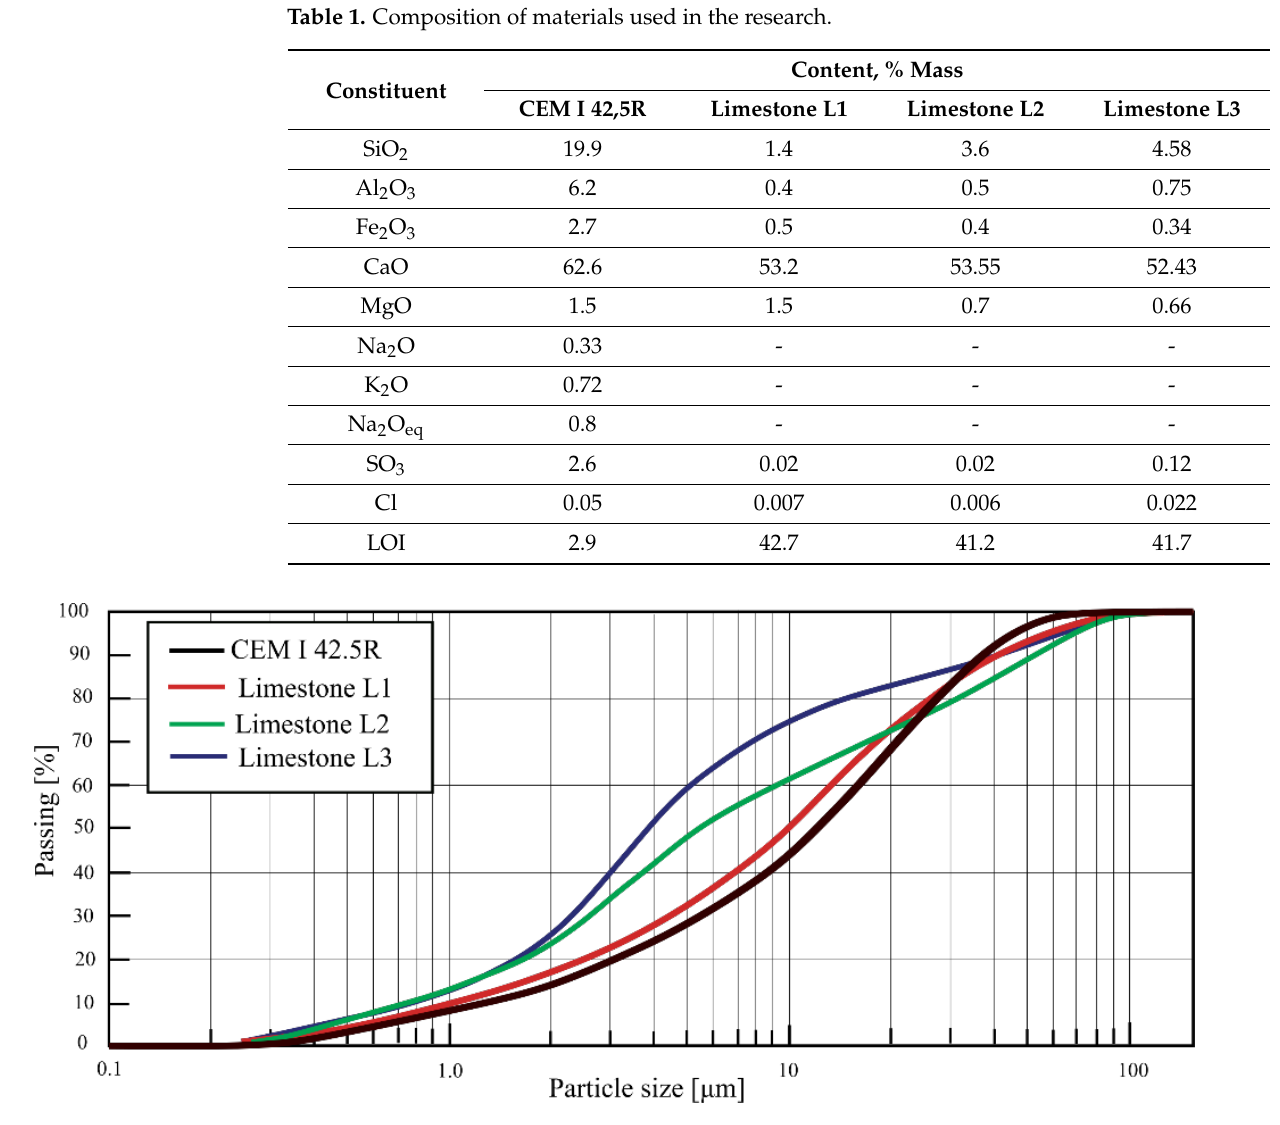
Figure 1. Particle size distribution of the cement, limestone and fly ash used in the research. Table 2. Composition of 1 m 3 of vibrated concrete with no air-entraining admixture.